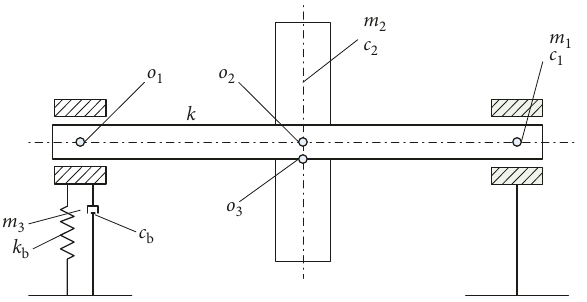
Figure 1: Bearing-rotor system with single pedestal